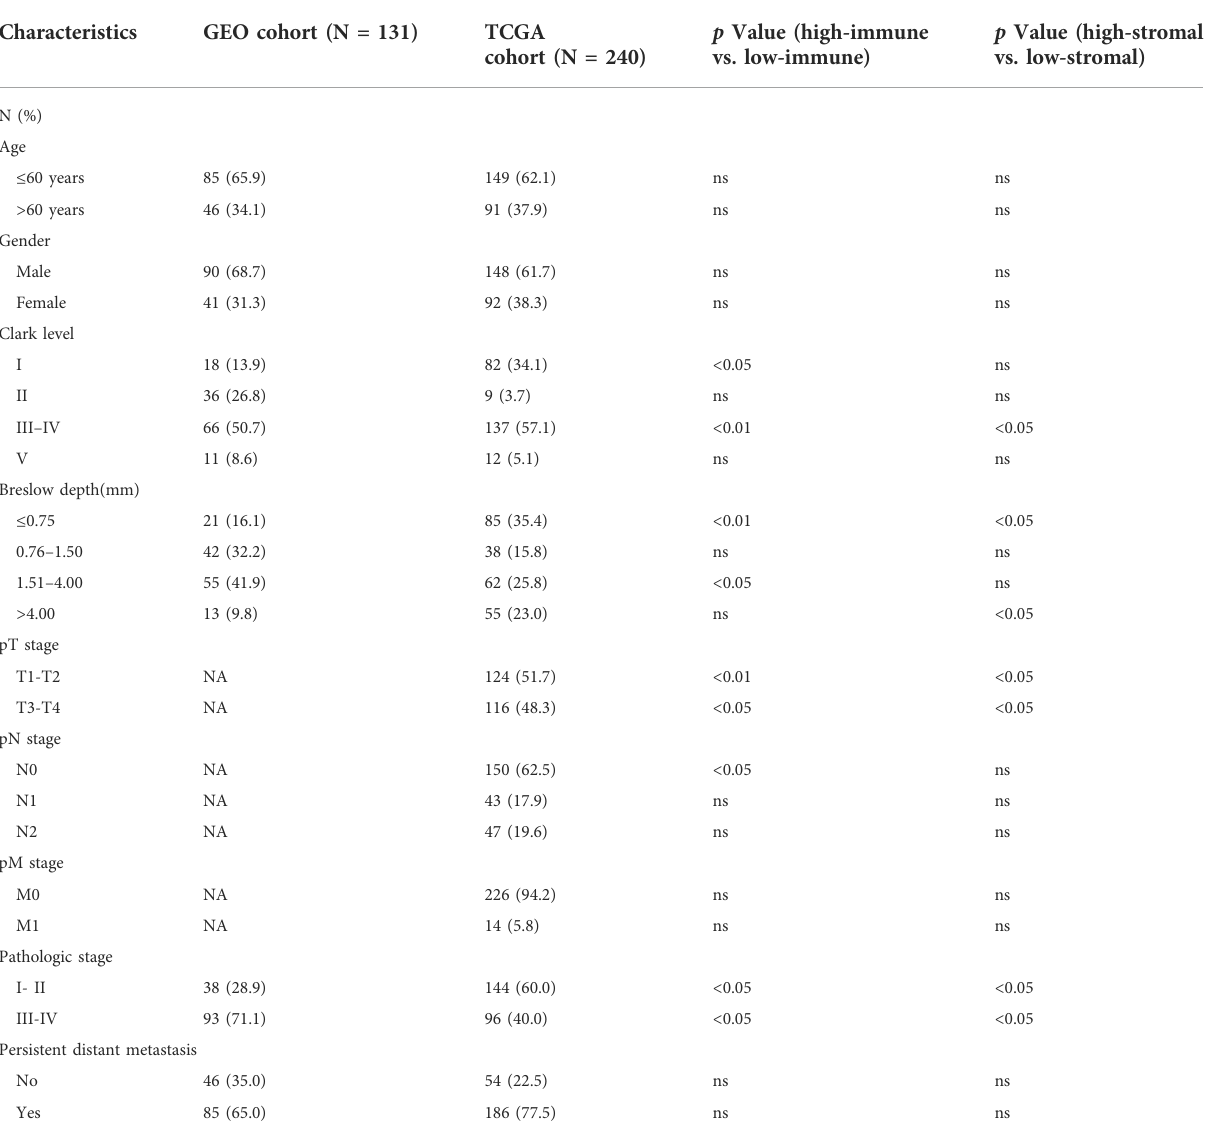
TABLE 1 Clinicopathological characteristics of SKCM